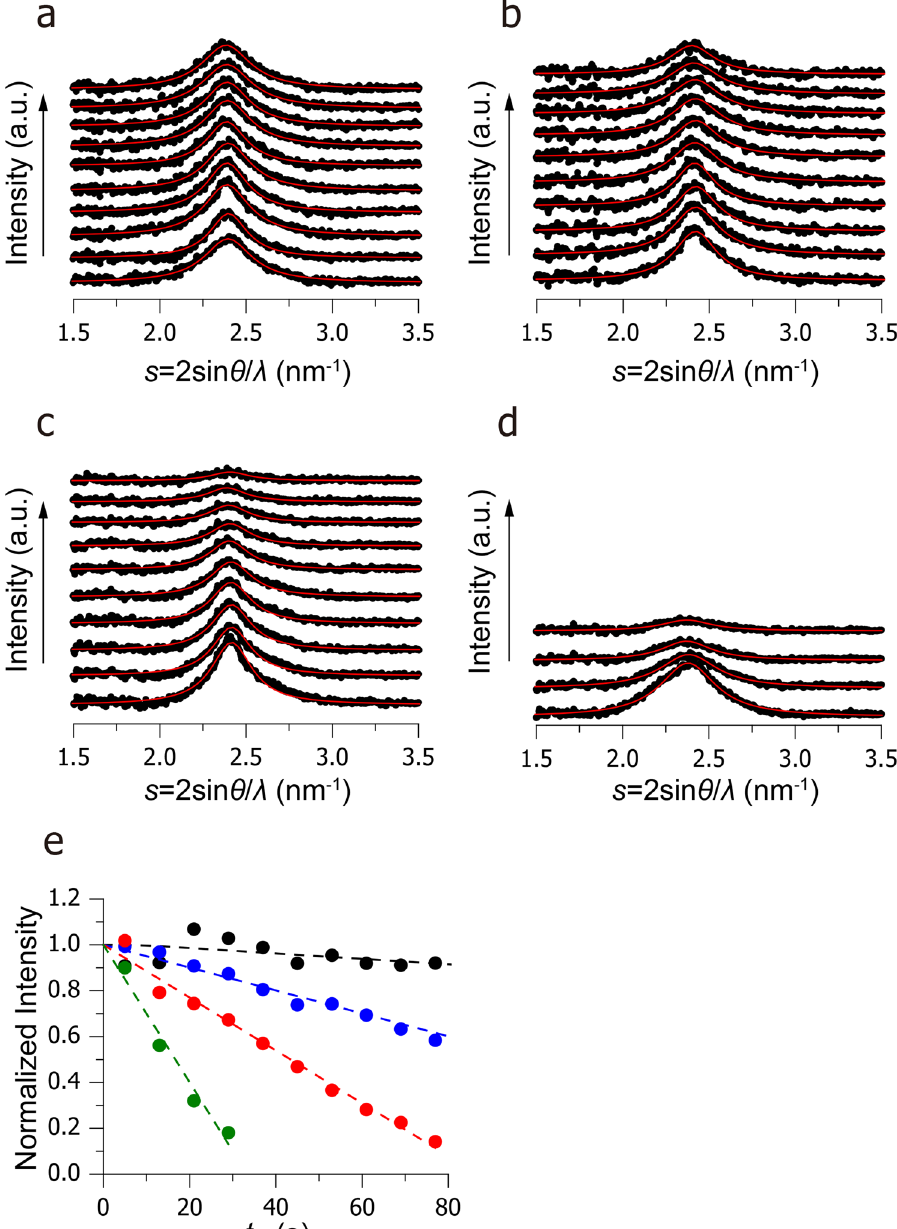
Figure 3. Kinetics of structural decay upon continuous irradiation with an electron beam. One-dimensional ED patterns at the electron flux of ( a ) 0.9 e/nm 2 ·s, ( b ) 2.3 e/nm 2 ·s, ( c ) 4.7 e/nm 2 ·s, and ( d ) 15.9 e/nm 2 ·s are shown. The data were obtained in the same region under continuous irradiation with the electron beam. The irradiation times t irr were 5 s, 13 s, 21 s, 29 s, 37 s, 45 s, 53 s, 61 s, 69 s, and 77 s from the bottom to top profiles. Each profile is fitted to a Lorentz function, and the fitting result is shown by a red profile. The selected area is 0.79 μm 2 , which corresponds to 1 μm in diameter. ( e ) Peak heights are plotted as a function of t irr under the electron flux of 0.9 e/nm 2 ·s (black), 2.3 e/nm 2 ·s (blue), 4.7 e/nm 2 ·s (red), and 15.9 e/nm 2 ·s (green). The dashed lines indicate linear fitting in the region t irr < 77 s for 0.9 e/nm 2 ·s − 4.7 e/nm 2 ·s and t irr < 29 s for 15.9 e/nm 2